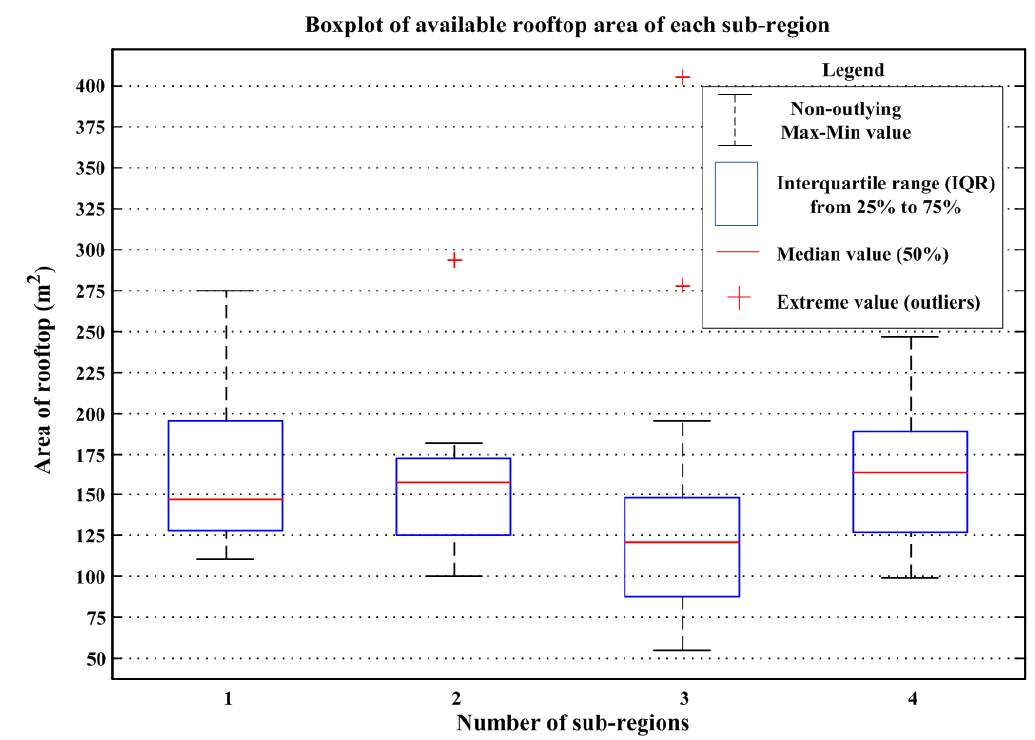
Figure 4. Boxplot of available rooftop area of each subregion in the study area.